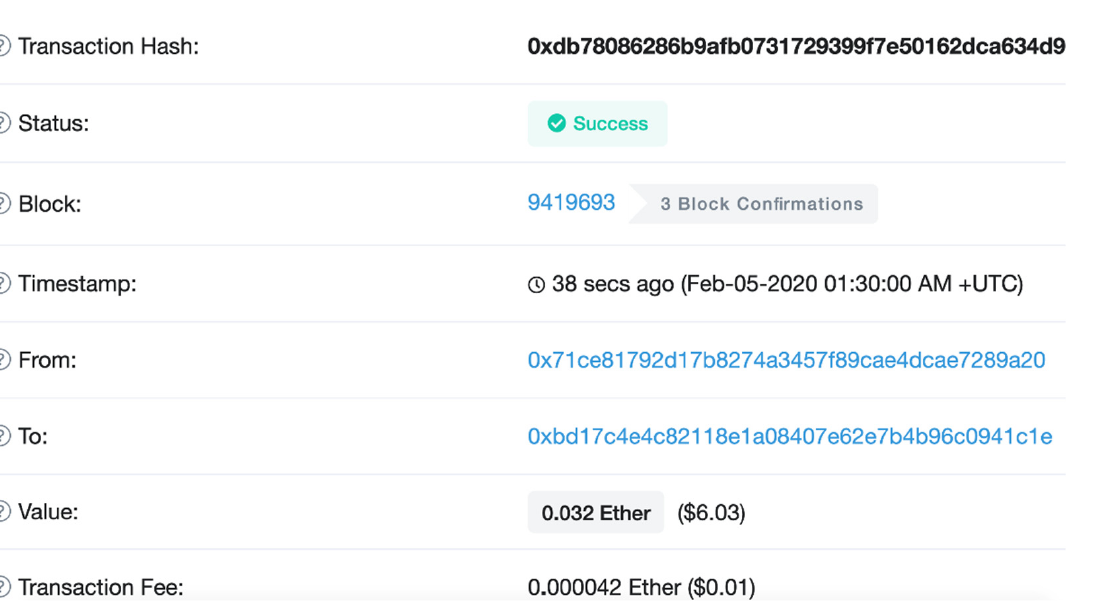
Figure 1. Example of details on Ethereum transfer [4].